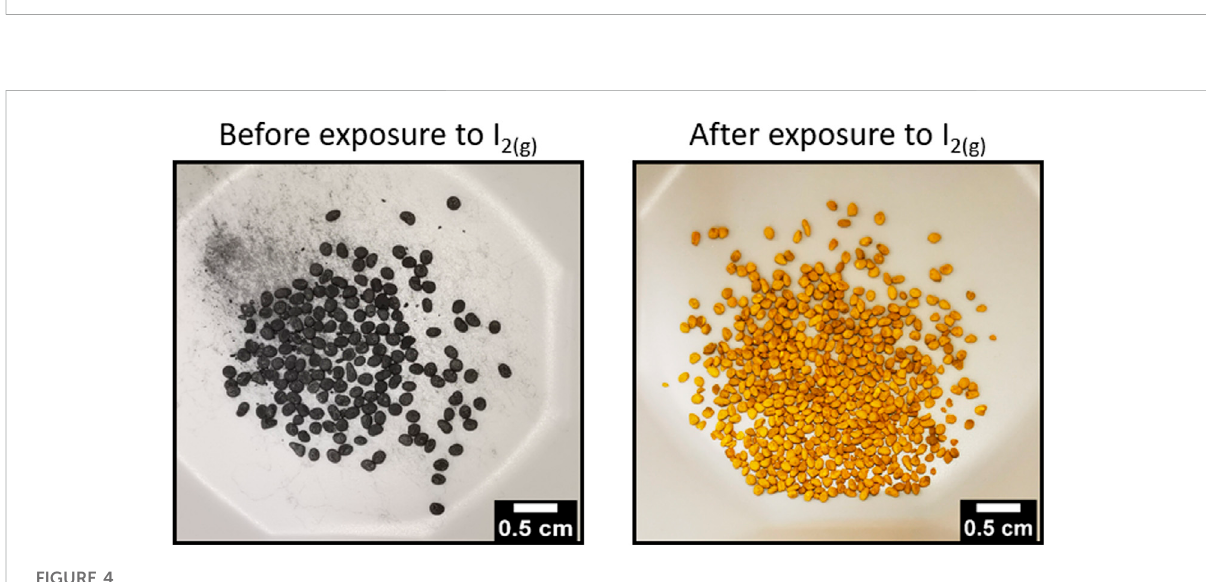
FIGURE 4 Sorbents calcined at 290 ° C before and after exposure to I 2(g)